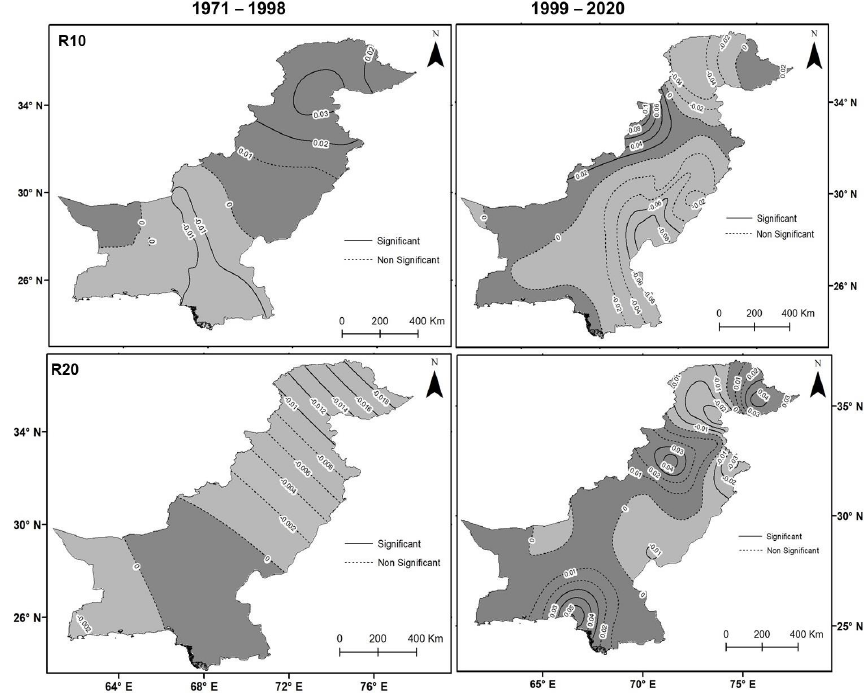
Figure 7. Spatial trends for extreme precipitation indices R10 and R20 (days) between 1971 and 1998 as well as 1999 and 2020. Dark color indicates the positive changes and light color shows the negative changes at 0.05 level of significance.